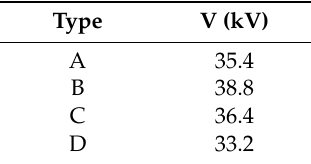
Table 4. Sliding flashover of all four bushing samples.